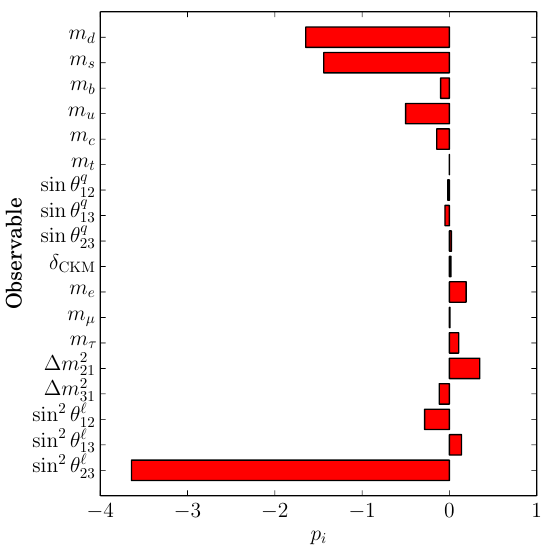
Figure 2 . Pulls p i for each observable in the extended model with normal neutrino mass ordering, given the set of parameter values that has the minimum value of the (cid:31) 2